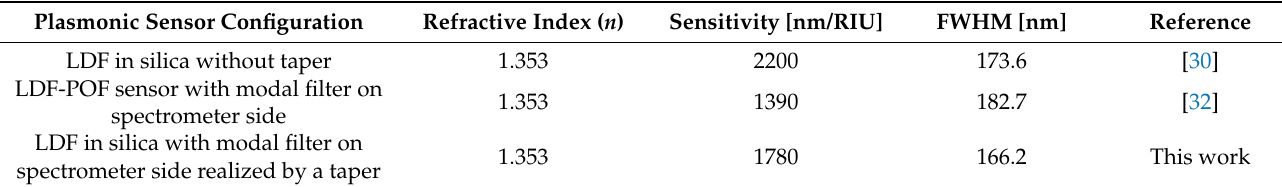
Table 2. Comparison of performances parameters relative to several configurations based on silica LDFs (without taper and with taper as a modal filter) and plastic LDFs (with a modal filter) at a fixed refractive index equal to 1.353. Plasmonic Sensor Configuration Refractive Index ( n ) Sensitivity [nm/RIU] FWHM [nm] Reference LDF in silica without taper 1.353 LDF-POF sensor with modal filter on 1.353 spectrometer side LDF in silica with modal filter on spectrometer side realized by a